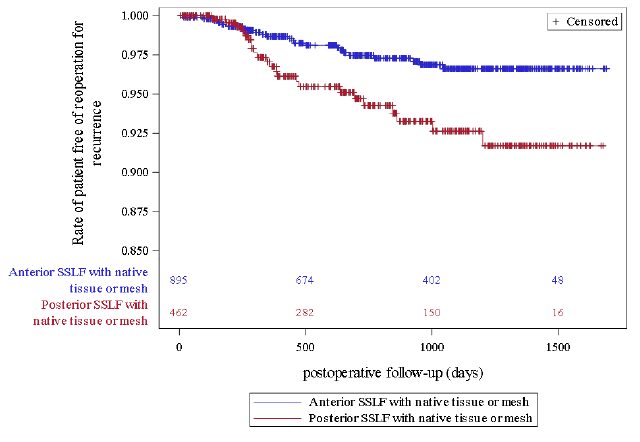
Figure 3. Kaplan – Meier curve for reoperation for pelvic organ prolapse recurrences comparing an- Figure 3. Kaplan–Meier curve for reoperation for pelvic organ prolapse recurrences comparing terior and posterior SSLF. anterior and posterior Table 5. Multivariate analysis with a propensity score.